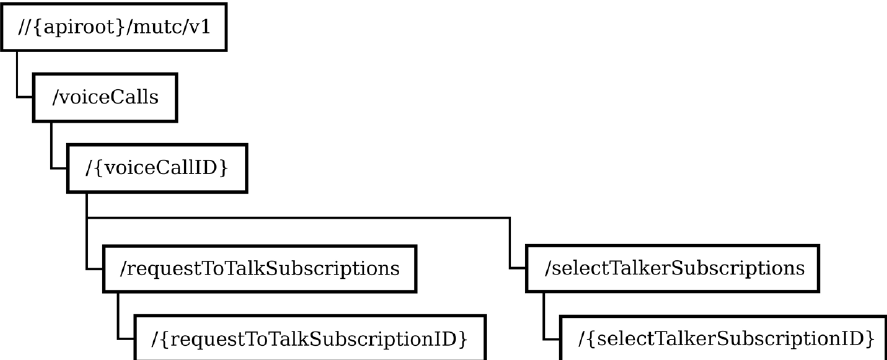
Figure 10. Structure of resource URIs related to multiuser talker control.